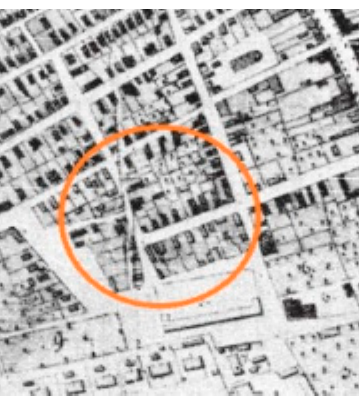
Figure 4. W е rthenpreis-Wolgenmuht’s plan of the City of Zemun with the Jewish quarter, 1780. Figure 4. W e rthenpreis-Wolgenmuht’s plan of the City of Zemun with the Jewish quarter,